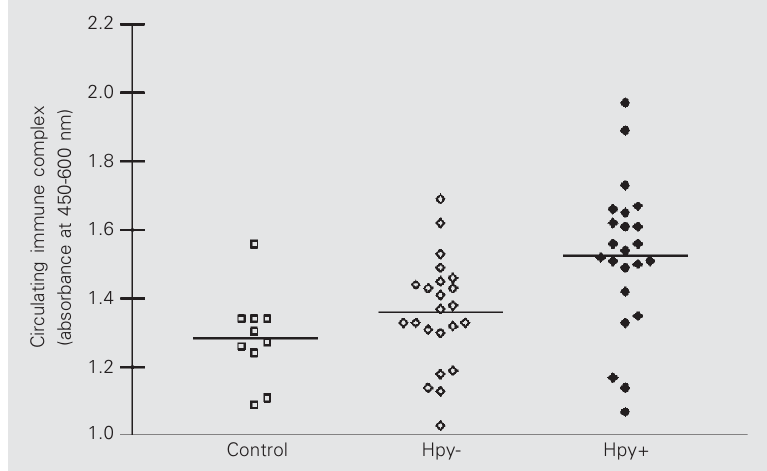
Figure 1. Serum levels of circulating immune complexes of anti-C1INH IgG autoantibodies as determined by immunocapture ELISA using goat anti-human C1INH and peroxidase- conjugated goat anti-human IgG. Circulating immune complex levels are reported as absorbance at 450-600 nm. Sera from the following groups were evaluated: healthy controls (N = 10), CIU patients without H. pylori infection (Hpy-, N = 23), and CIU patients with H. pylori infection (Hpy+, N = 23). Different circulating immune complex levels were demonstrated in the three groups by the Kruskal-Wallis test (P <